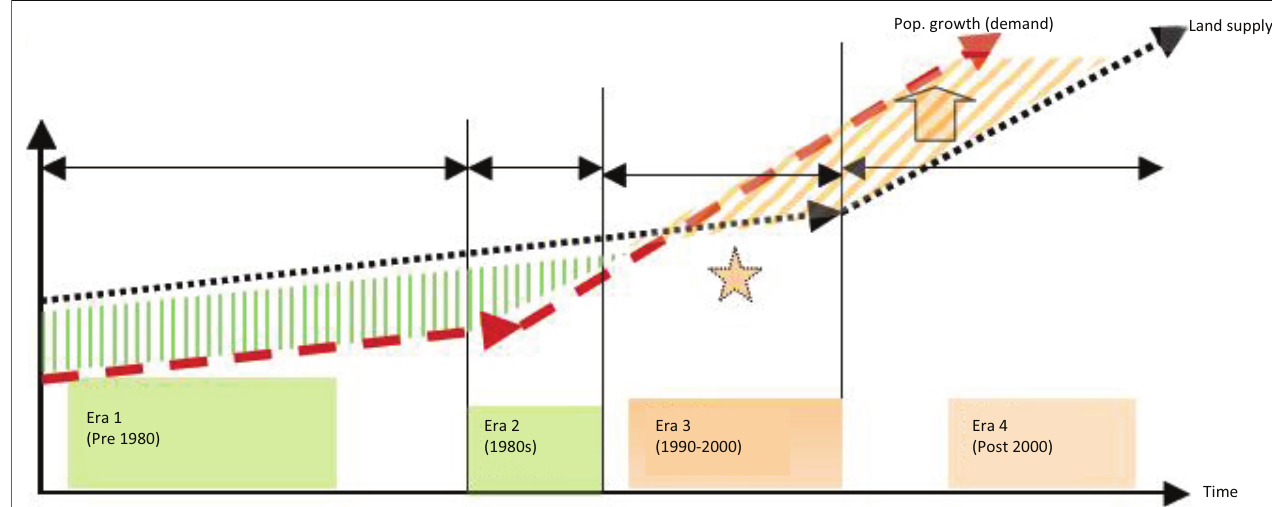
FIGURE 1: Land supply and demand in Zimbabwean urban